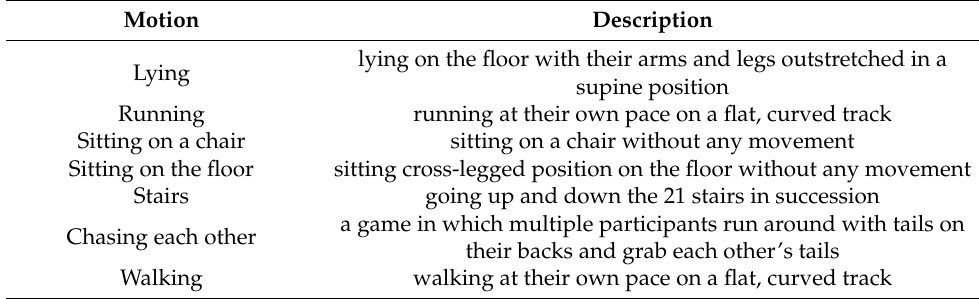
Table 1. Motions used for the classification and their descriptions.